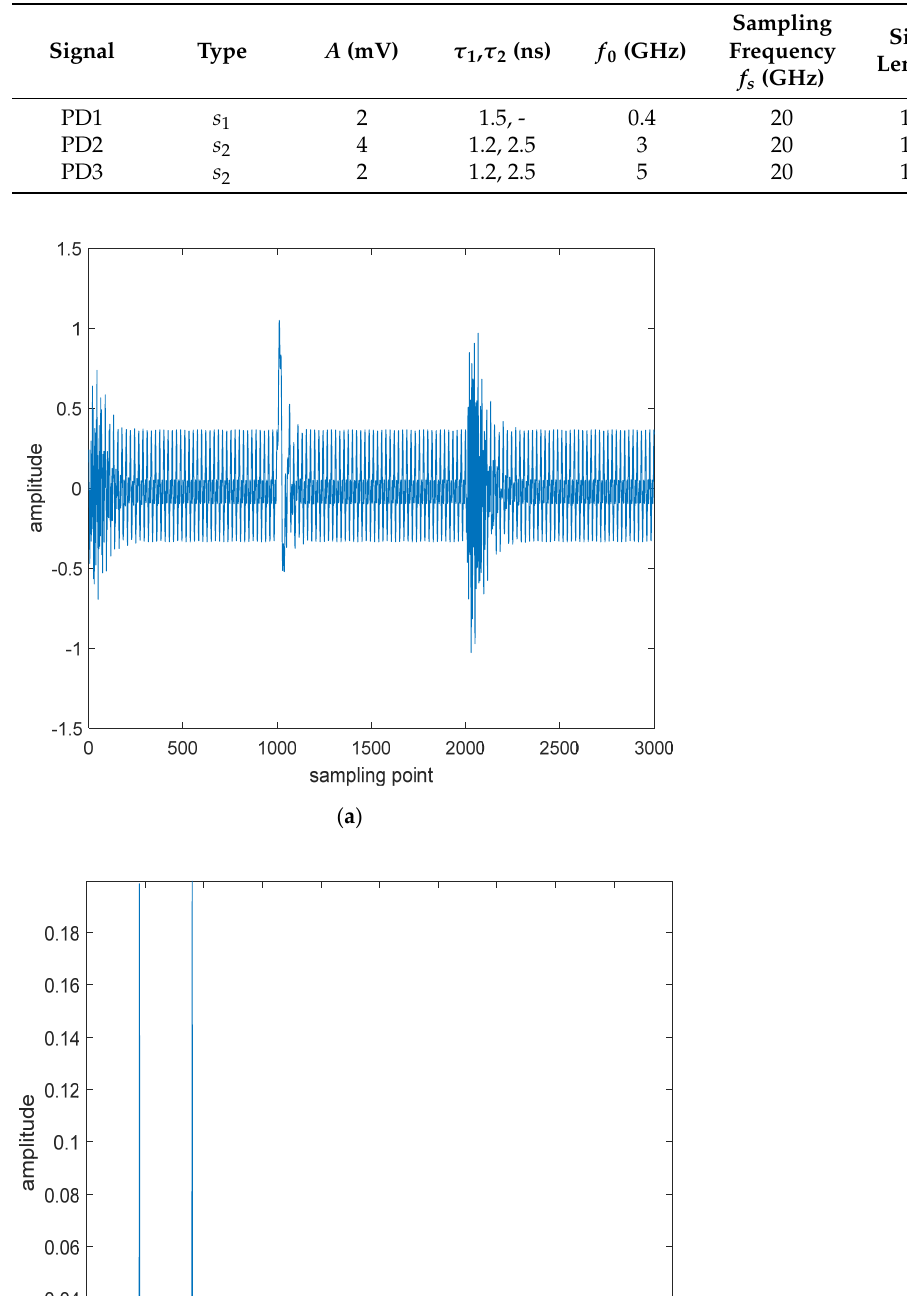
Figure 3. Pure PD signal. ( a ) In the time domain and ( b ) in the frequency domain.